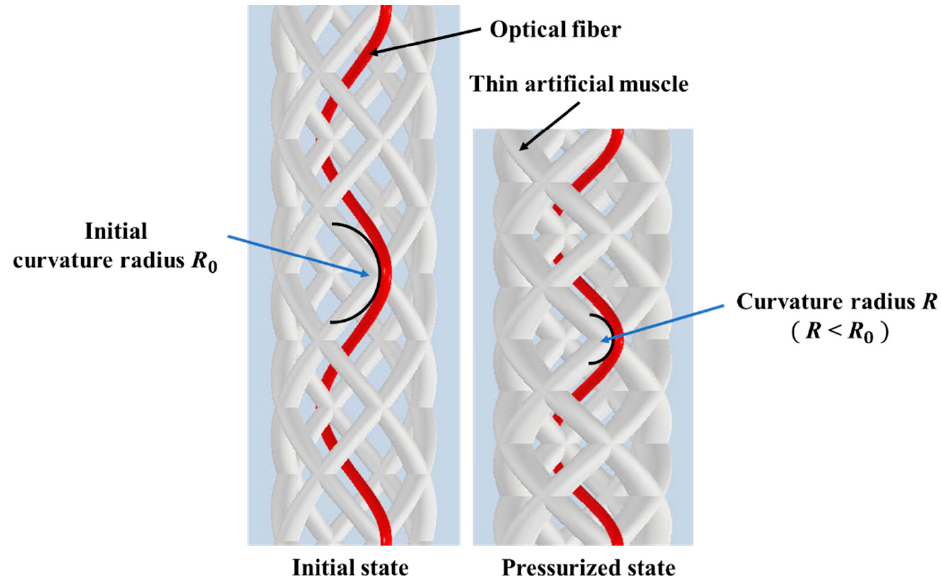
Figure 9. Integrating the optical fiber sensor in the active string actuator.